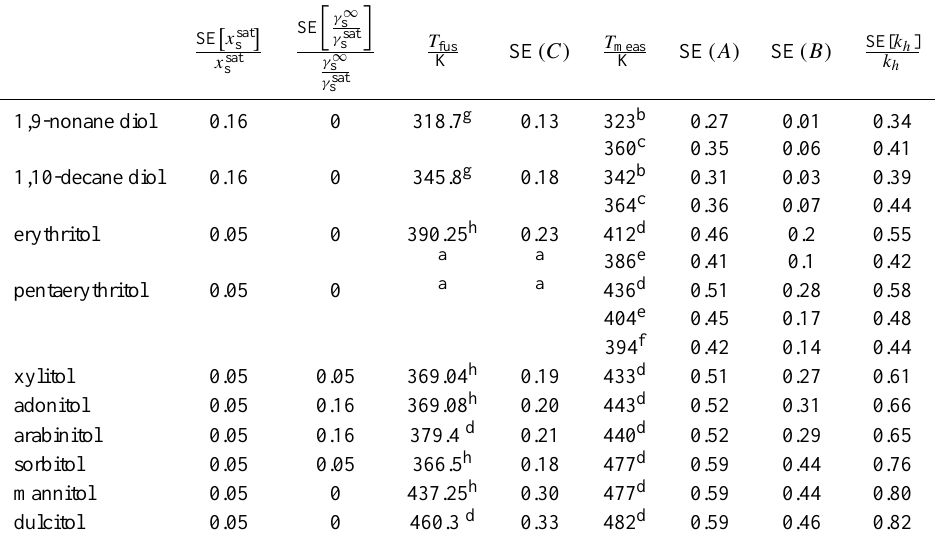
Table 8. Estimated relative standard errors on x sat s , γ Sects. A3, A4 and